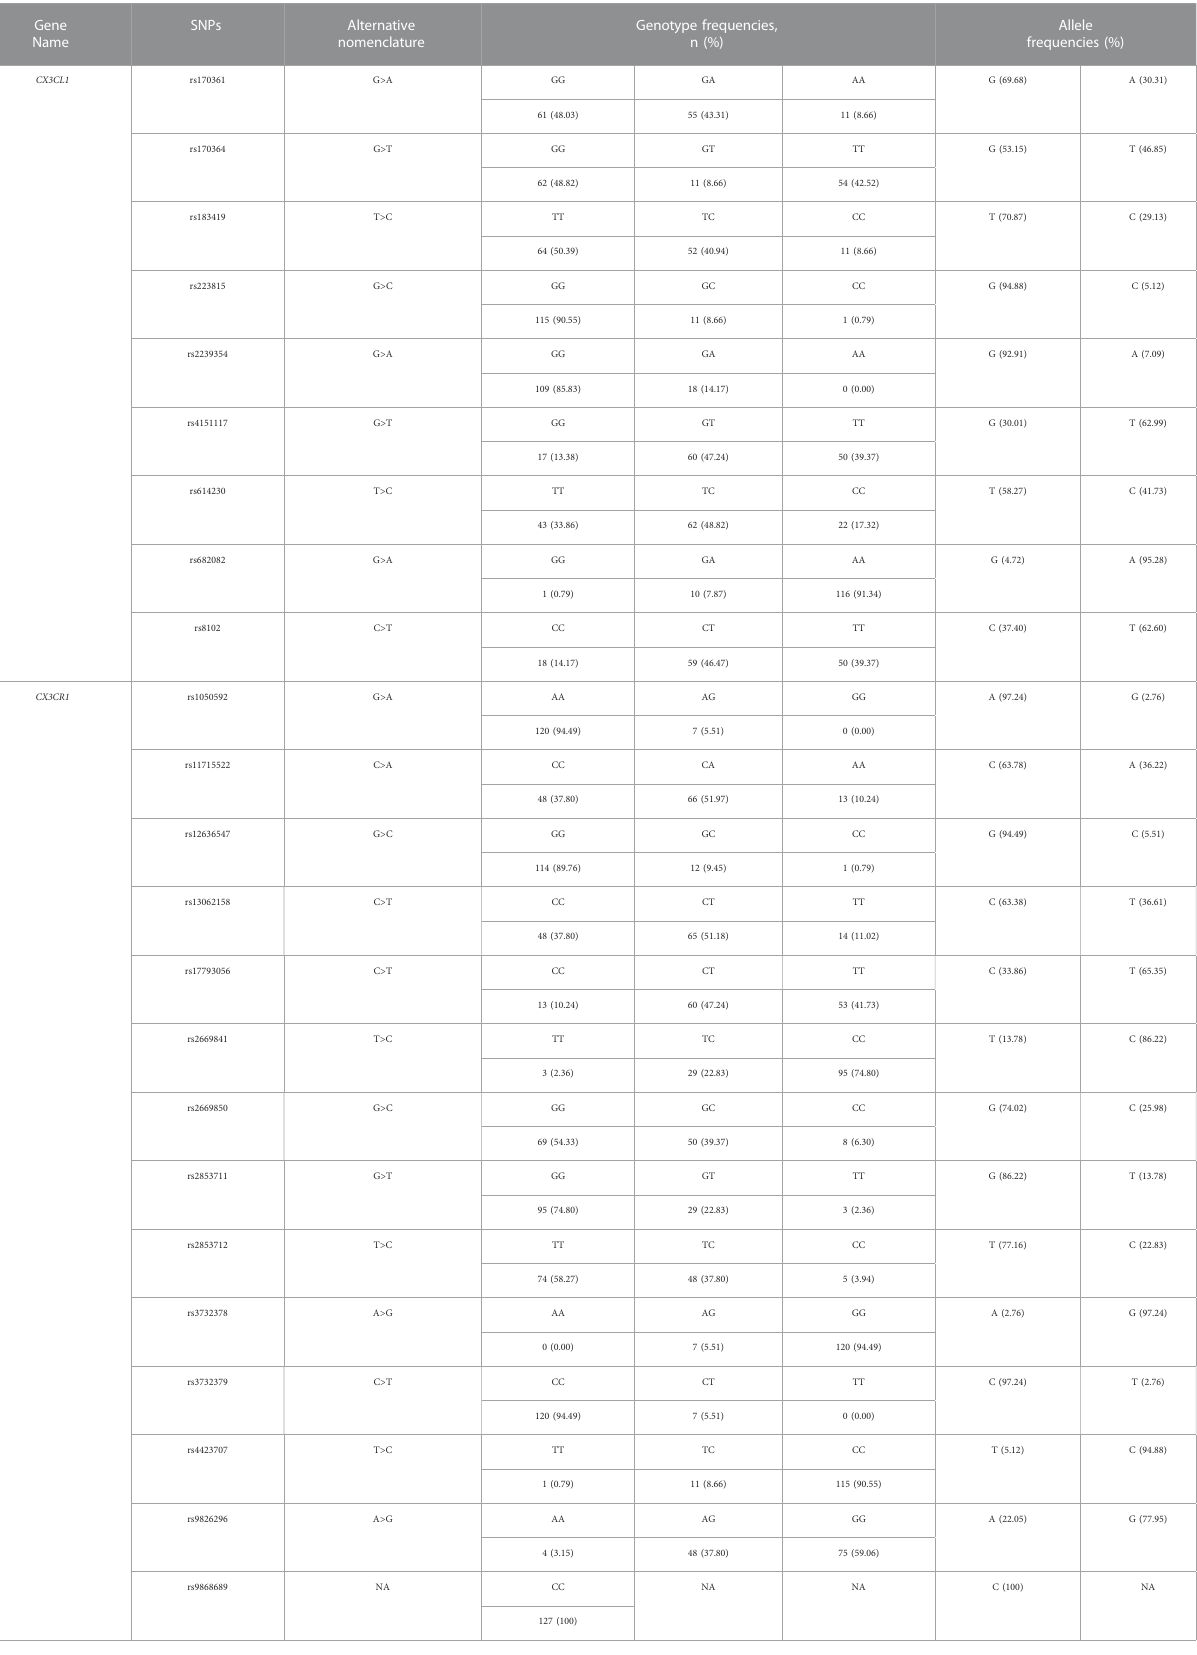
TABLE 2 Genotypes and allele frequency of CX3CL1/CX3CR1 SNPs in carboplatin-treated ovarian cancer patients ( n = 127). Gene